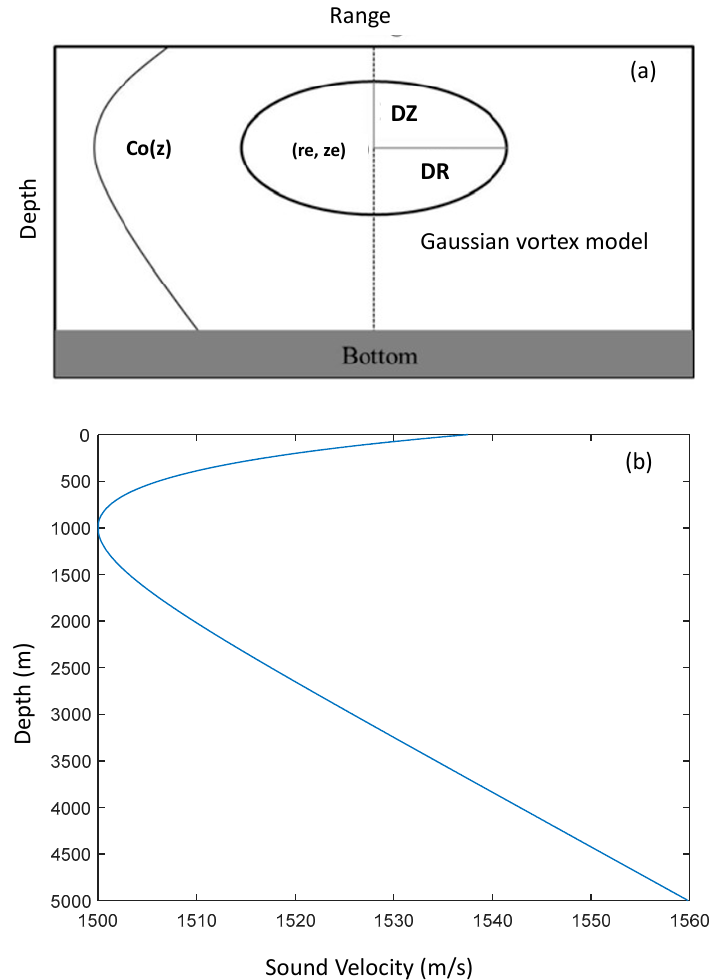
Figure 7. ( a ) Schematic diagram of the 2D model of Gaussian Ocean Vortex, ( b ) Vertical distribution of deep-sea sound of deep-sea sound channel.